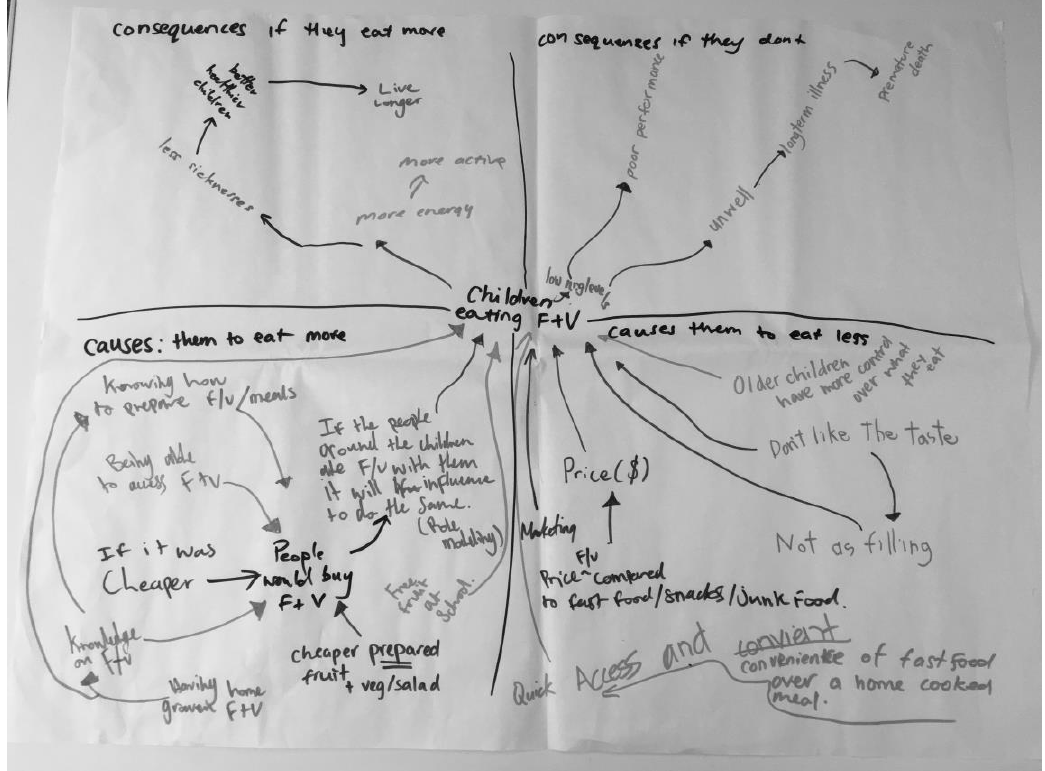
Figure 4. Example of completed causes and consequences template.